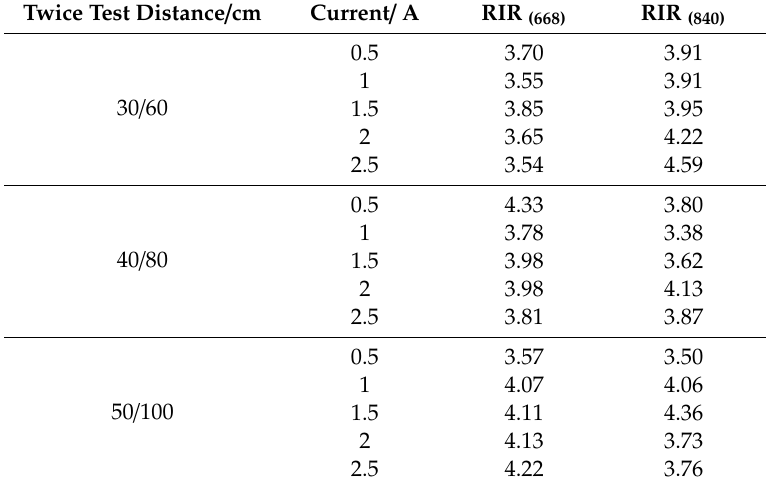
Table 5. Ratio of red light and infrared radiation intensity of di ff erent driving currents at twice the projection